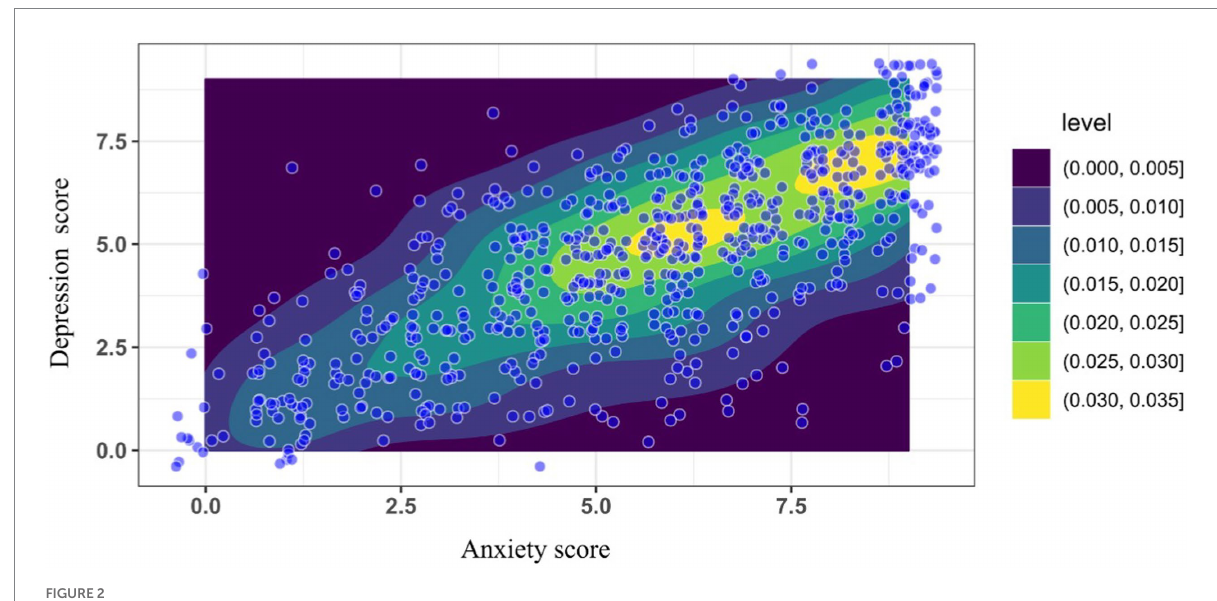
FIGURE 2 Linear regresión for anxiety as predictor of